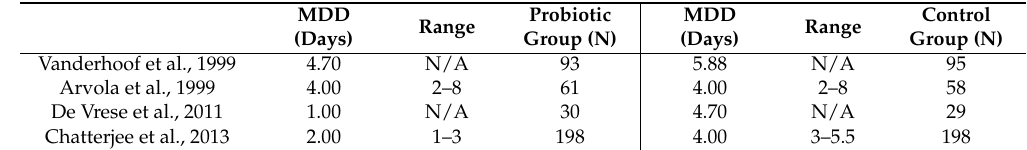
Table 3. Mean duration of diarrhea (MDD).